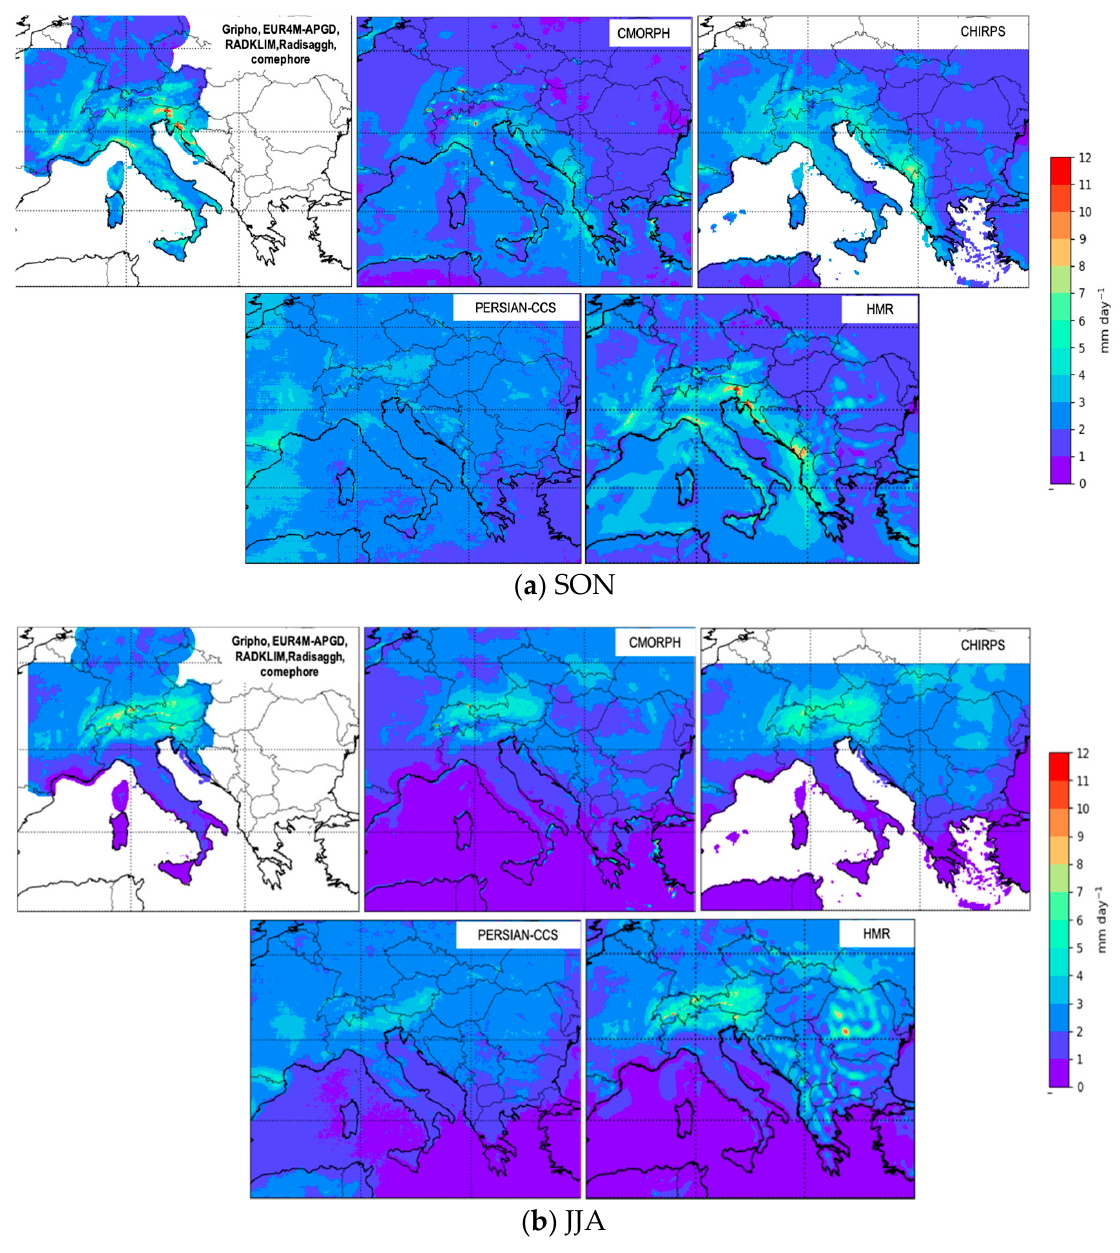
Figure 3. Seasonal mean daily precipitation calculated for different observational datasets described in Table 2 for autumn ( a ) and summer ( b ) seasons.